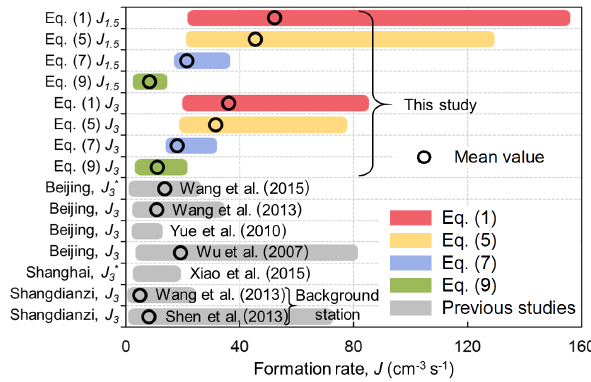
Figure 7. Estimated J 1 . 5 and J 3 using different equations. Previ- ously reported J 3 values in China were included for comparison. The ends of the colored rectangles correspond to the minimum value and the maximum values, respectively. J ∗ : the upper size bound to 3 estimate formation rate, d u , is 6nm (rather than 25nm) in Wang et al. (2015) and Xiao et al.